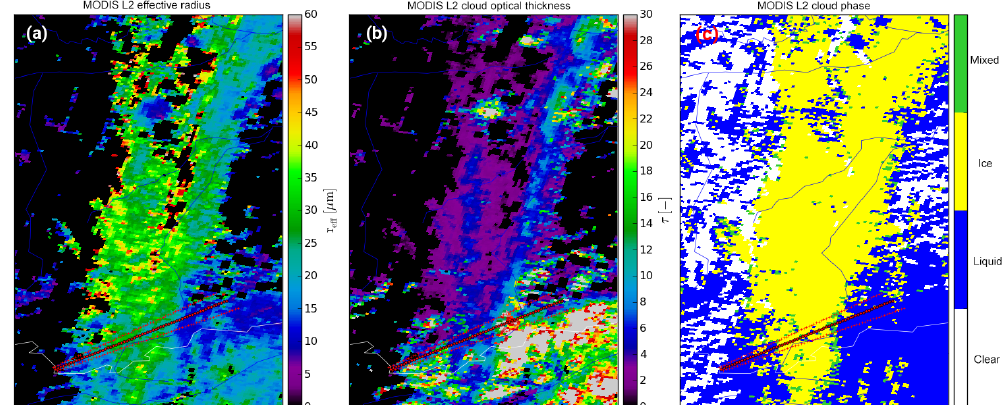
Figure 10. MODIS collection 6 effective radius (a) , optical thickness (b) and cloud mask (c) for 2 October 2012, 10:20UTC. Red lines of symbols are related to cross sections in time assuming advection (compare Fig. 12). The first symbol at the lower left end of these lines marks the UFS position.